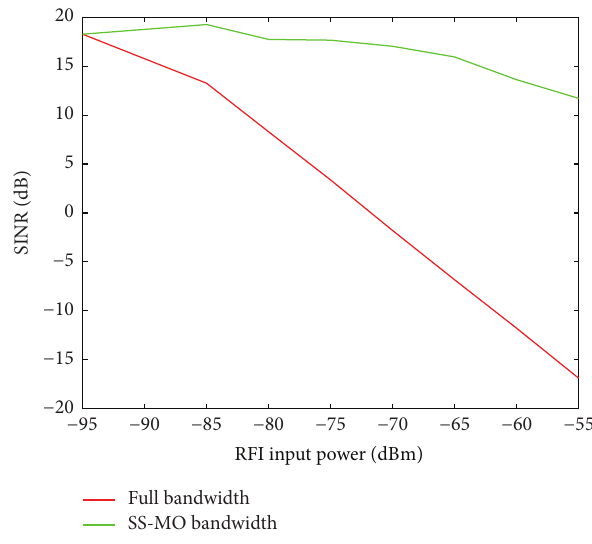
Figure 7: The SINR results of the narrowband RFI experiment. These results indicate that the SS-MO technique significantly improves SINR when high power, narrowband interference is present in band to the harmonic step-frequency